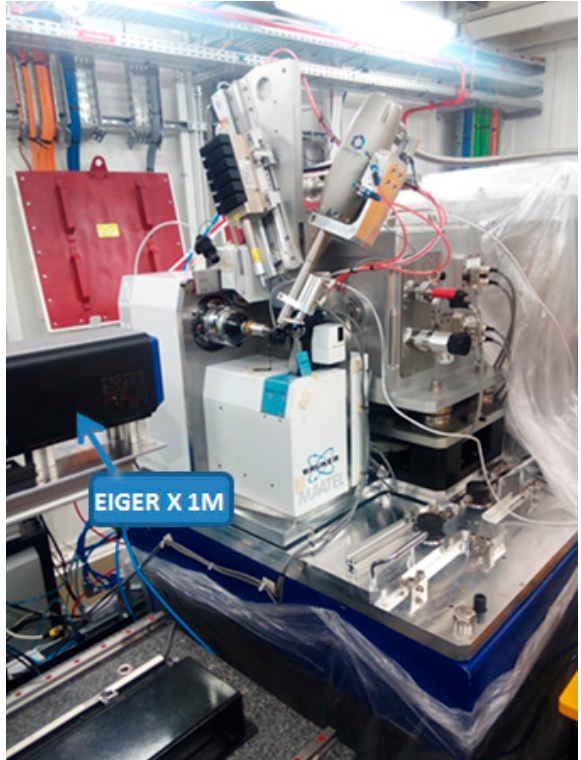
Figure 1. Photograph of the experimental setup at Proxima 2A beamline. The lysozyme crystal was mounted on an MD2 goniometer and cryo-cooled during the data collection with an Eiger X 1M